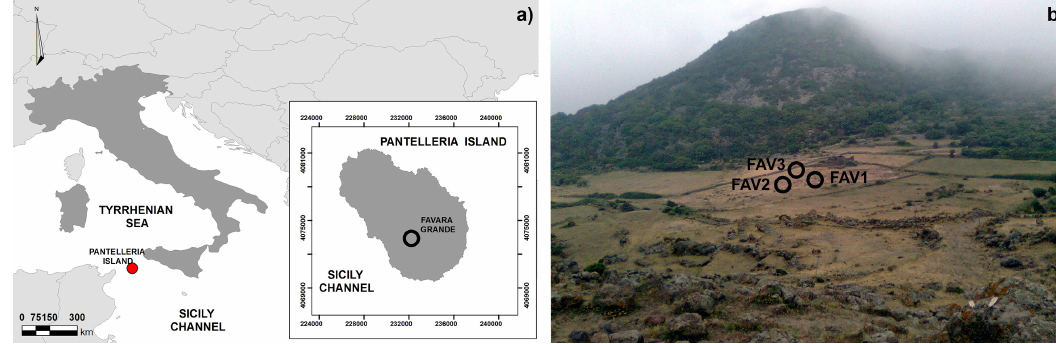
Figure 1. (a) Pantelleria (Italy) and (b) the three main sampling points at the geothermal field of Favara Grande.